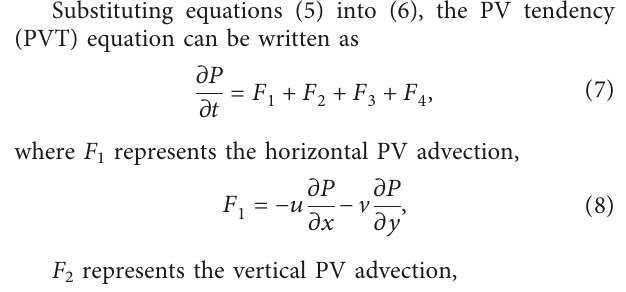
Figure 6: Tracks of Typhoons Tembin and Bolaven (a) and a “Fujiwhara” diagram for the binary interaction between them (b) in the NoM experiment from 1200 UTC 23 August to 1200 UTC 27 August (interval: 6 hours; red dots: Tembin; blue dots: Bolaven). In (b), distances are in degrees latitude. Dots are centroid-relative positions. The radius of dash circle is 6.5 degrees. The origin of coordinate denotes the geographical center between the two vortices. The 500hPa streamline at 0000 UTC 25 August as well as the 850hPa wind fields (interval: 1 ) in the CTL (c, e) and NoM experiments (d, 3m s −